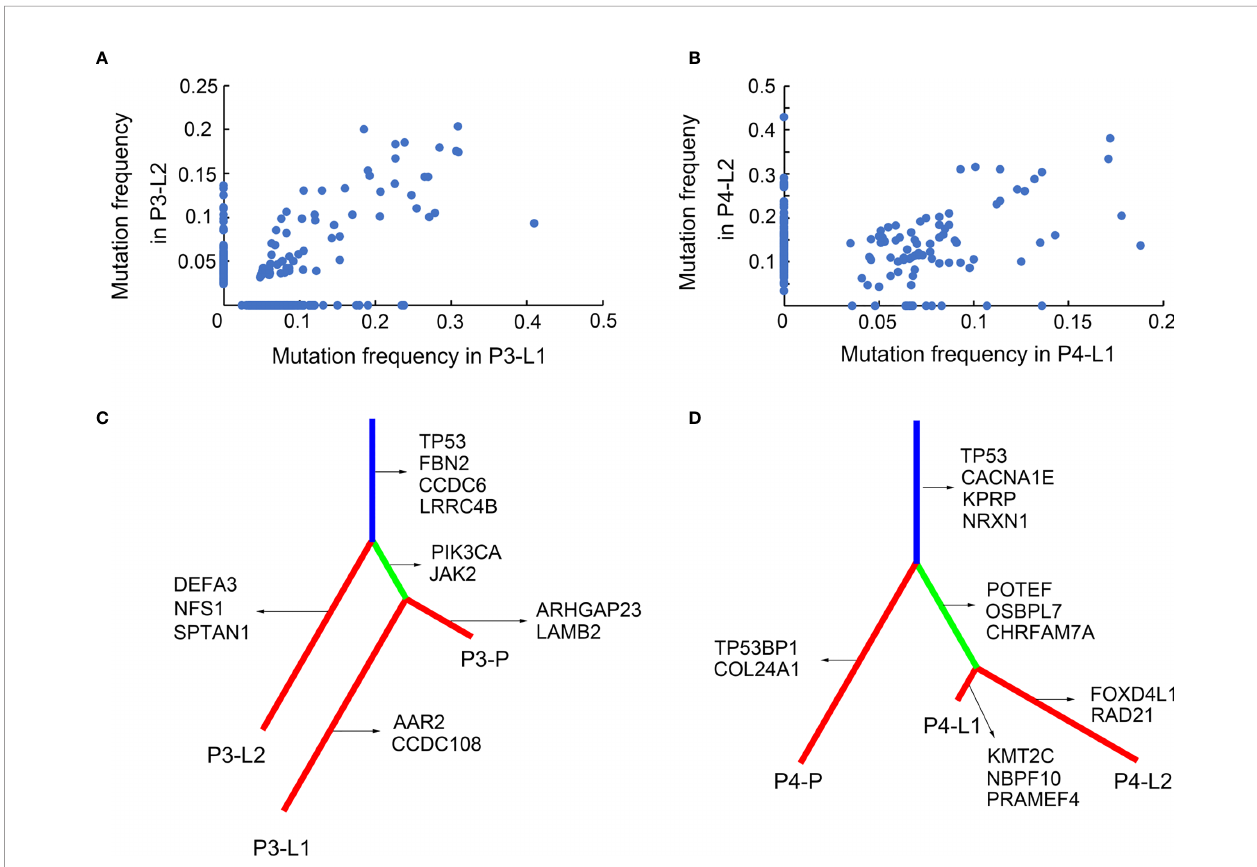
FIGURE 2 | SNV subclonal architecture and phylogenetic analysis. (A) The mutation frequencies of nonsynonymous SNVs were shown in two different LN sites in Pt.3. (B) The mutation frequencies of nonsynonymous SNVs were shown in two different LN sites in Pt.4. (C) A phylogenetic tree based on SNVs in Pt.3. The genes with inferred driver mutations corresponding to individual branches and trunk were indicated. (D) A phylogenetic tree based on SNVs in